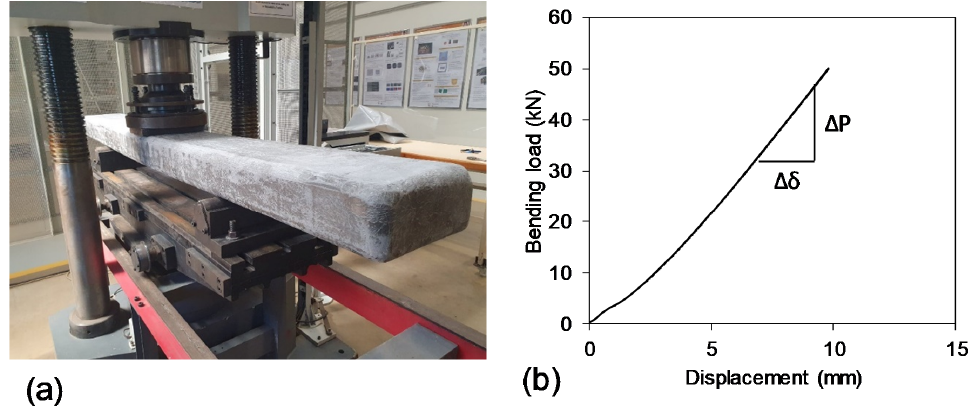
Figure 3. Non-destructive three-point bending test ( a ) test setup and ( b ) load-displacement behaviour. Figure 3b plotted the load-displacement curve where it can be seen that the bending behaviour is almost linear up to 50 kN load. The effective modulus of elasticity of the sleeper was found 5.15 GPa as determined by Equation (1), where a , L , I and Δ P /Δ δ are shear span, span, effective moment of inertia of the sleeper, and slope of the load–dis- placement curve, respectively. The MOE for softwood timber sleeper can be as low as 7.4